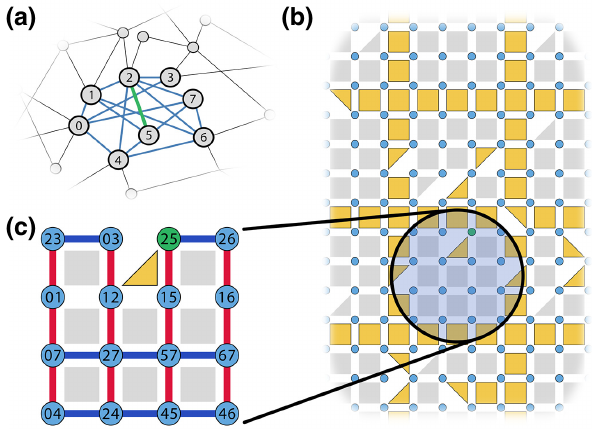
FIG. 1. The modularization of a parity-compiled problem. (a) The problem graph to be implemented, with a subgraph high- lighted in blue. (b) The implementation layout of the parity- encoded problem. The blue dots represent parity qubits, while the gray (yellow) squares and triangles represent implicitly preserved (explicitly enforced) three- and four-body constraints. Explicitly enforced constraints are used to divide the layout into modules. (c) One module of the layout, corresponding to the highlighted subgraph in (a), with terms of the driver Hamiltonian illustrated by red and blue lines. The modularization leads to a highly paral- lelizable circuit implementation of the required driver terms. The green highlighting illustrates the correspondence of interactions in (a) to parity qubits in (b) and